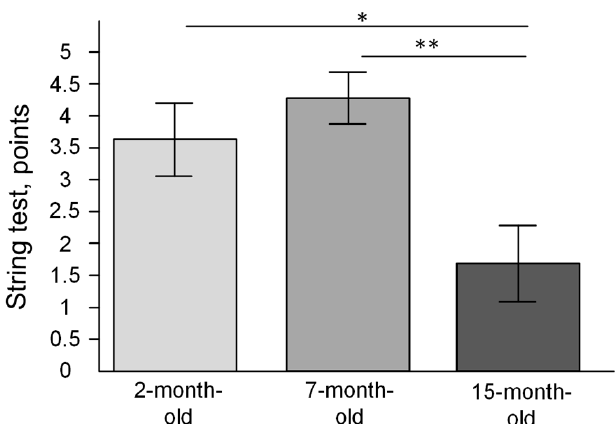
Figure 9. The results of the string test (scores). * p < 0.05; ** p < 0.01 differences between age groups were statistically significant according to the Mann–Whitney test. The 2-month-old mice (n = 9), 7-month-old mice (n = 9), 15-month-old mice (n = 9).